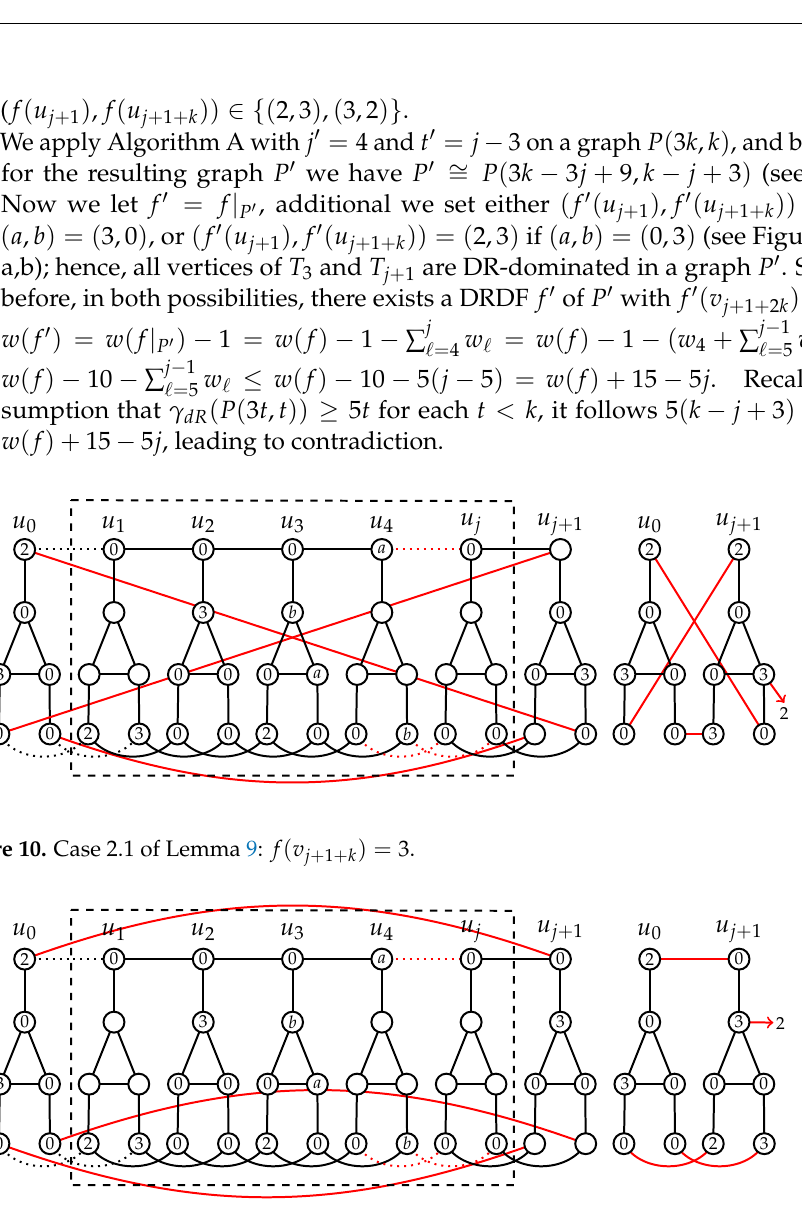
Figure 11. Case 2.2 of Lemma 9: f ( v j + 1 ) =